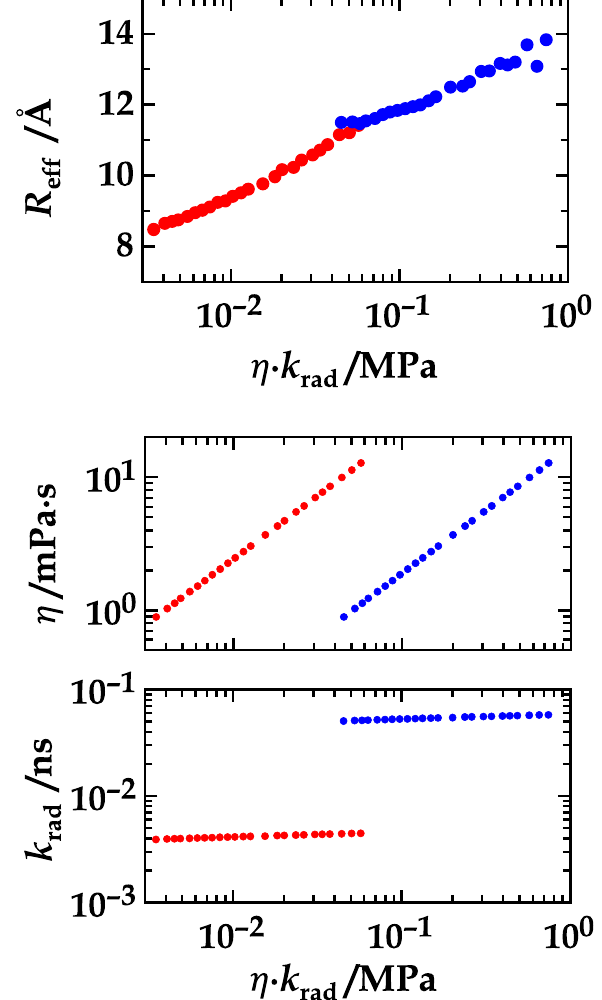
Figure 5. ( Top panel ) The effective donor/acceptor distance in NAla-(GS) 6 -Dbo-NH 2 (red) and 5-F-Trp-(GS) 6 -Dbo-NH 2 (blue) plotted against the product, η k rad , of the viscosity of the aqueous ethylene glycol solutions and the intrinsic decay rates (reciprocal radiative lifetimes) of NAla in NAla-(GS) 6 -NH 2 and of 5-F-Trp in 5-F-Trp-(GS) 6 -NH 2 (blue). ( Middle panel ) The corresponding viscosity values and ( Bottom panel ) radiative decay rates of NAla in NAla-(GS) 6 -NH 2 (red) and of 5-F-Trp in 5-F-Trp-(GS) 6 -NH 2 (blue).